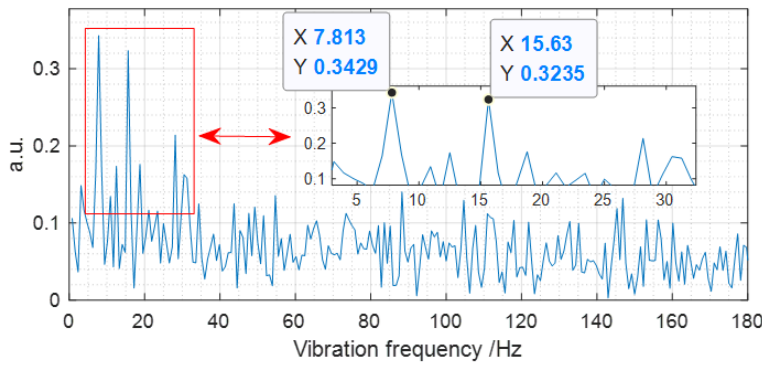
Figure 5. The spectrum of the vibration event loaded on MMF.